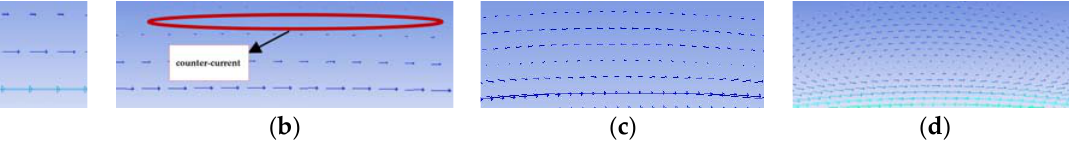
Figure 9. Velocity vector diagram of arc-shaped texture at different texture depths. ( a ) h = 1 µ m; ( b ) h = 5 µ m; ( c ) h = 8 µ m; ( d ) h = 15 µ m.